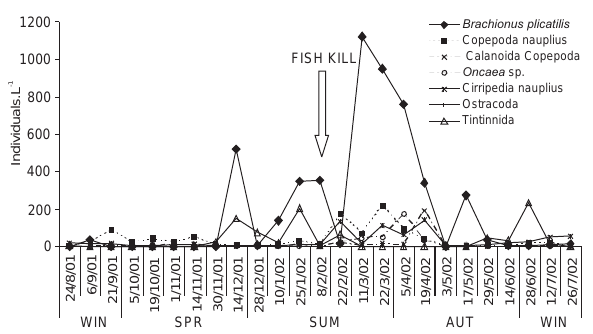
Figure 10. Temporal variation of density medians of the most fre- quently found taxa in Rodrigo de Freitas Lagoon. (WIN) Winter, (SPR) spring, (SUM) summer, (AUT) autumn.